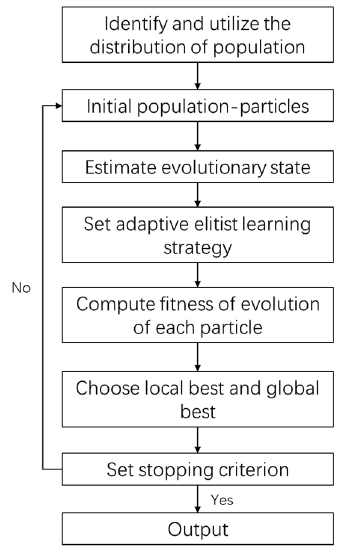
Figure 1. The workflow chart of APSO.